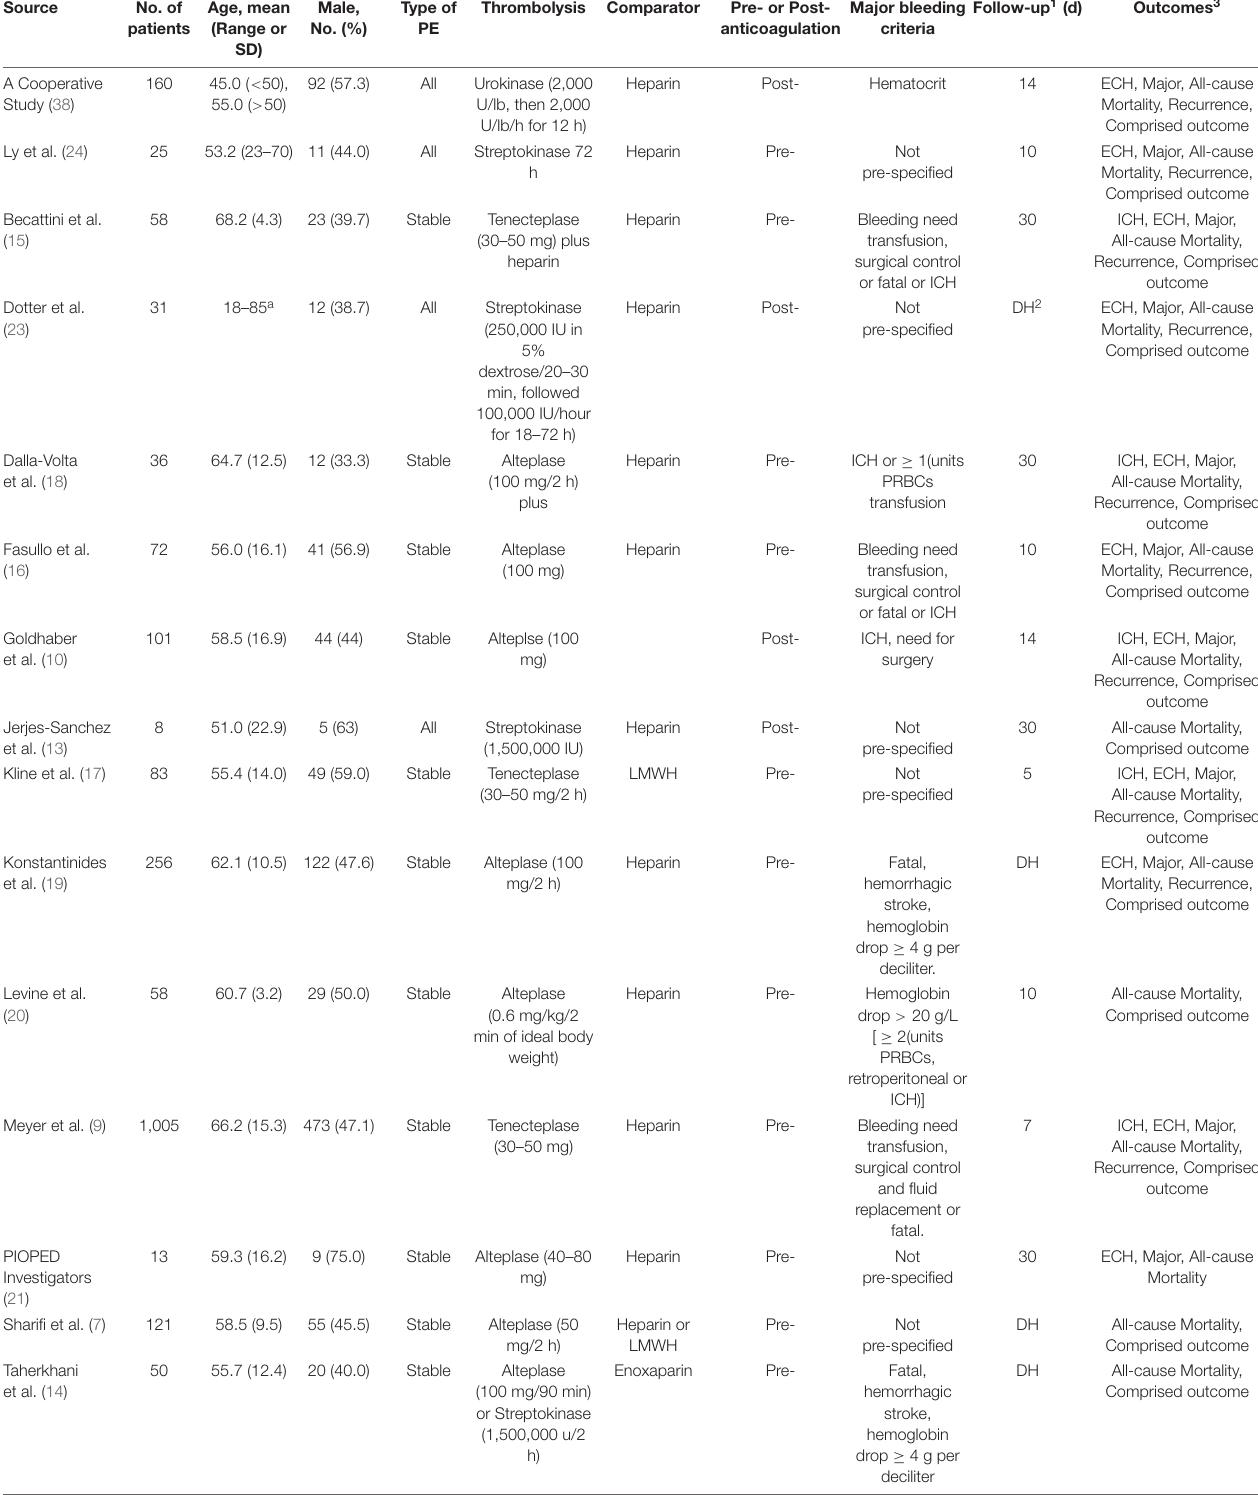
TABLE 1 | Baseline characteristics of